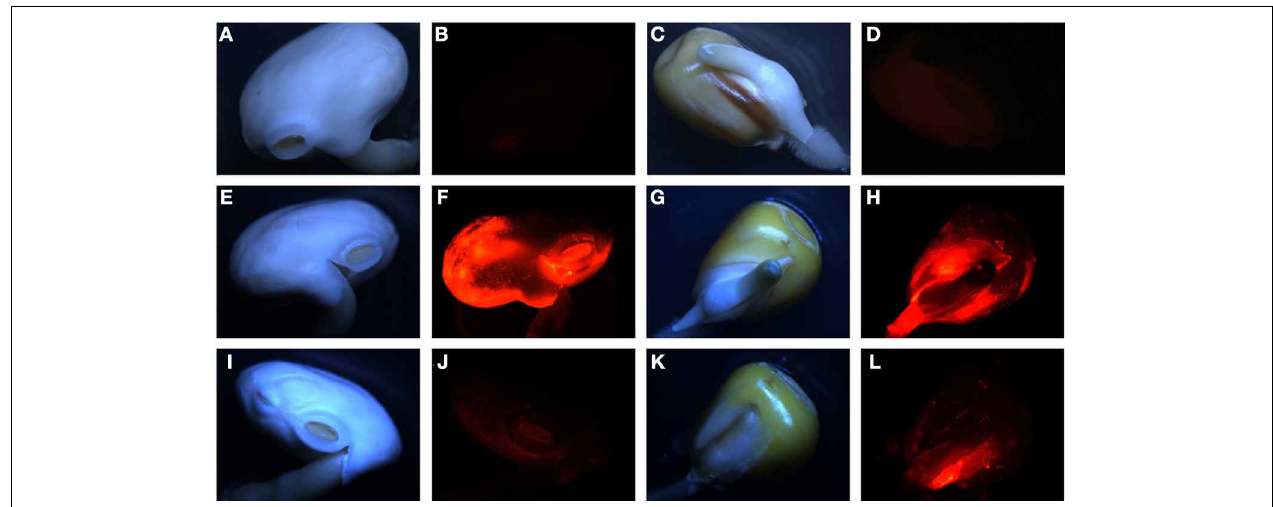
FIGURE 4 | Representative pictures of seed colonization of lupin (A,B,E,F,I,J) and maize (C,D,G,H,K,L) by dsRED-tagged wild-type (E–H) or (cid:2) oxc mutant (I–L) after 3 days. A-D: non inoculated seeds. Pictures were